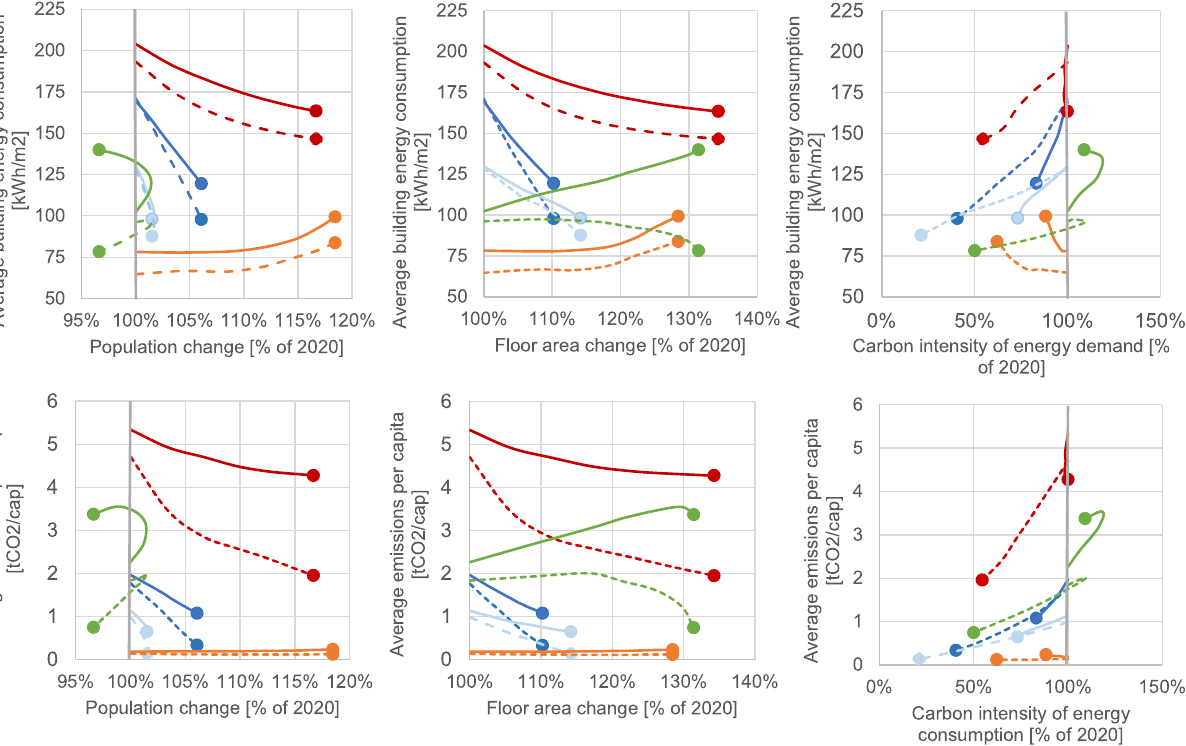
Fig. 4 Changes in demands and services from 2020 to 2050 (X-axes: population, fl oor area, and carbon intensity of fi nal energy consumption (FEC) change. Y-axes: average building energy demand and CO 2 emissions per capita in the different scenarios by regions and countries). The oval arrow shows the direction of evolution over time, and the oval indicates the value for